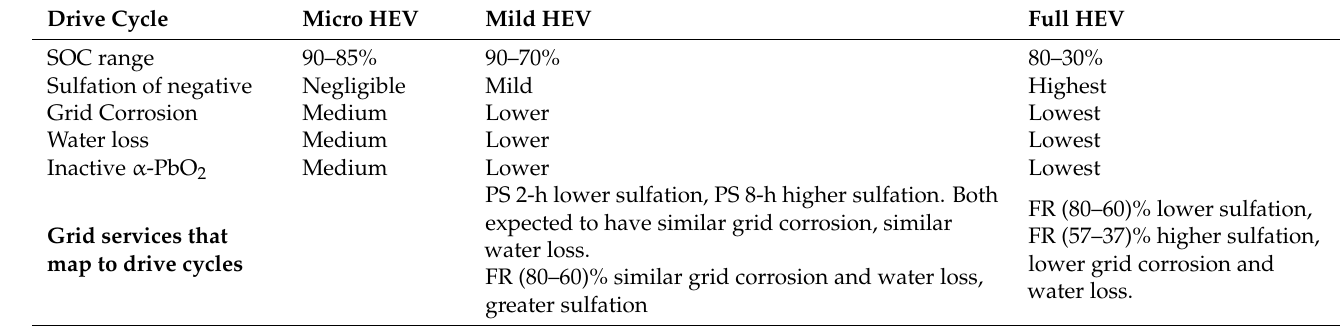
Table 4. Mapping of Grid Services Degradation with HEV